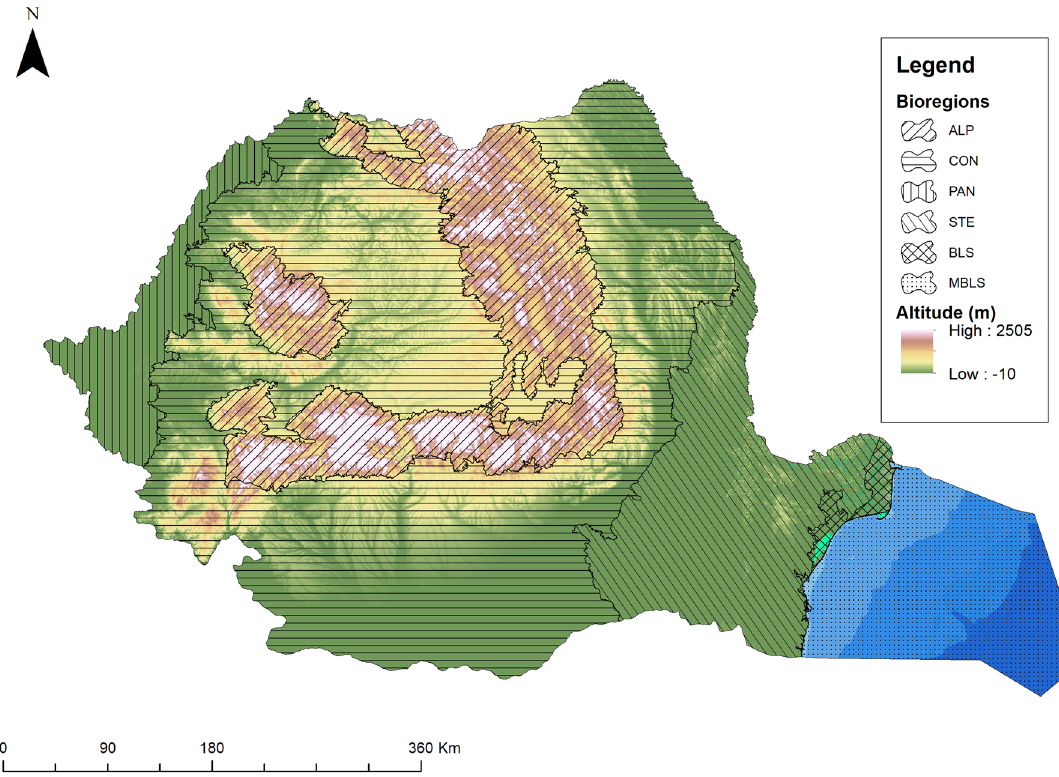
Figure 2. The geomorphological units and biogeographical regions of Romania (the map was generated using ArcGIS software, version 10.4, provided by Environmental Systems Research Institute, Redlands CA, 2013 54